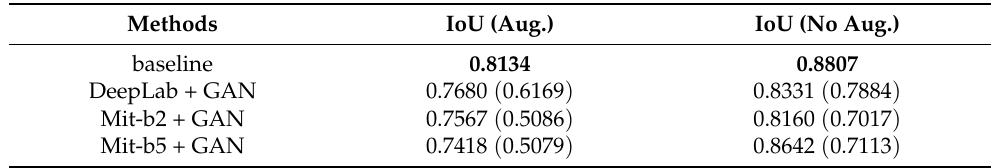
Table 3. Performance comparison of different generators.